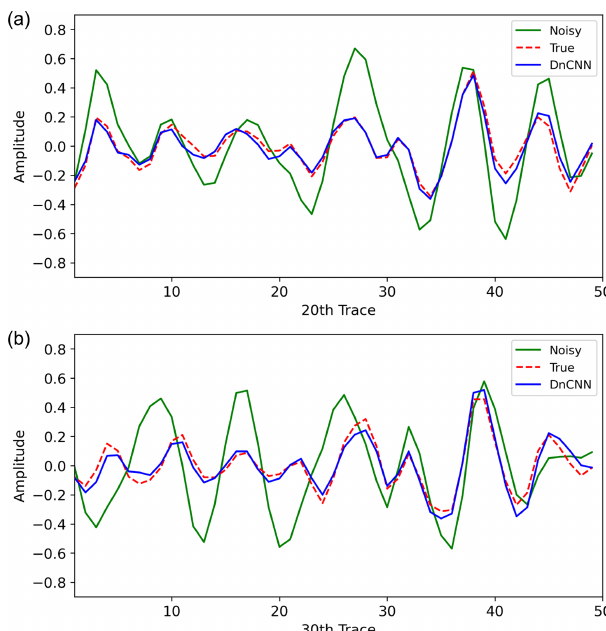
Figure 10. Comparison of the extracted traces before applying the D1 model and after applying the 40th epoch of the D1 model. The solid green line shows the trace from the noisy data, the dashed red line shows the trace from the ground truth, and the solid blue line shows the trace from the denoised data after applying the D1 model. Panel (a) shows the 20th and (b) shows the 30th vertical trace of the last test patch in Fig. 7.